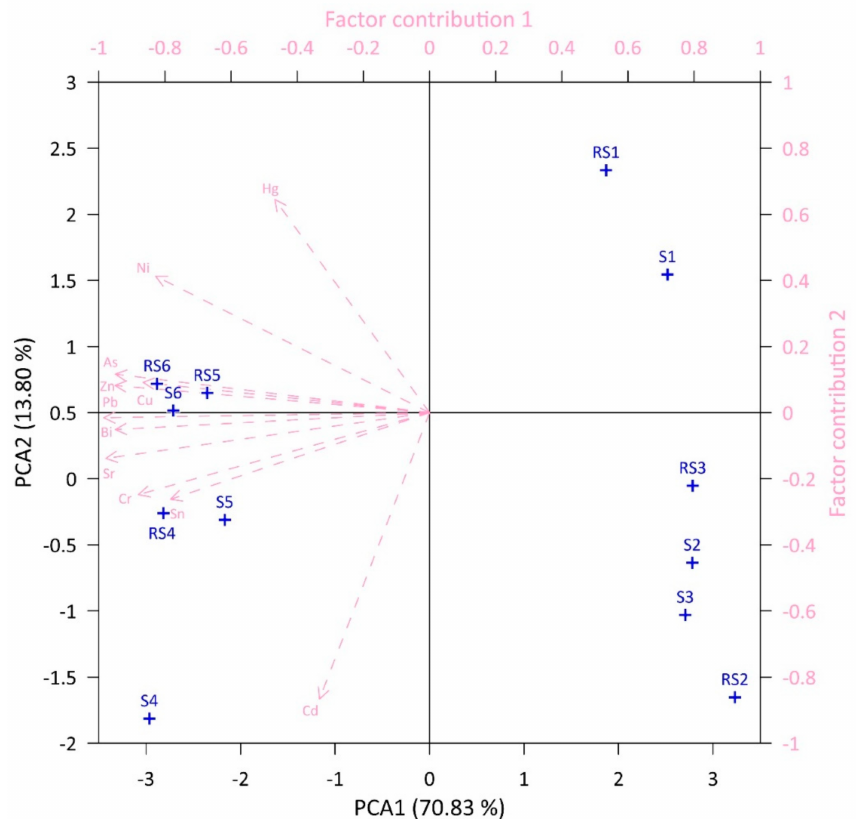
Figure 12. PCA analysis figure combining locations and metal(oids)